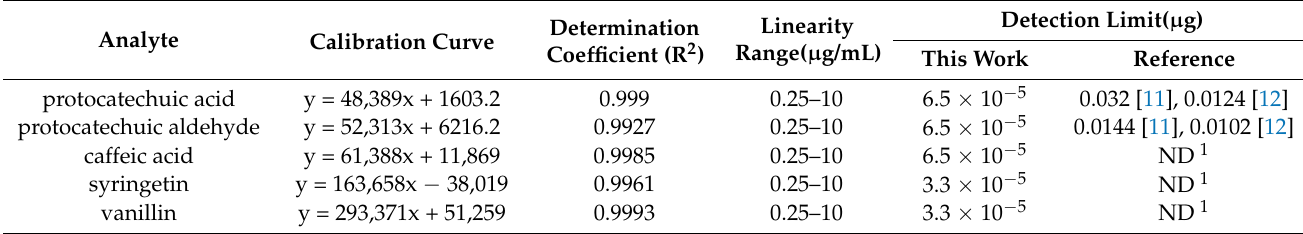
Table 3. Analytical performance of LVSS-MEKC for five compounds.